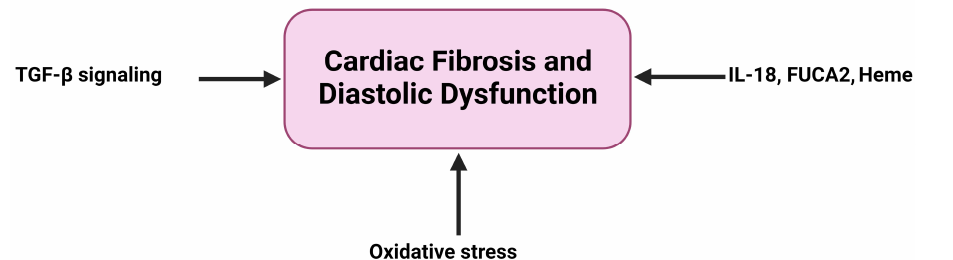
Figure 2. Summary of the inflammatory mechanisms associated with cardiac fibrosis and diastolic dysfunction in animals with SCD (with the relevant reports that describe them) addressed in the current review manuscript. TGF- β : transforming growth factor beta, IL-18: interleukin-18, and FUCA2: -L-fucosidase